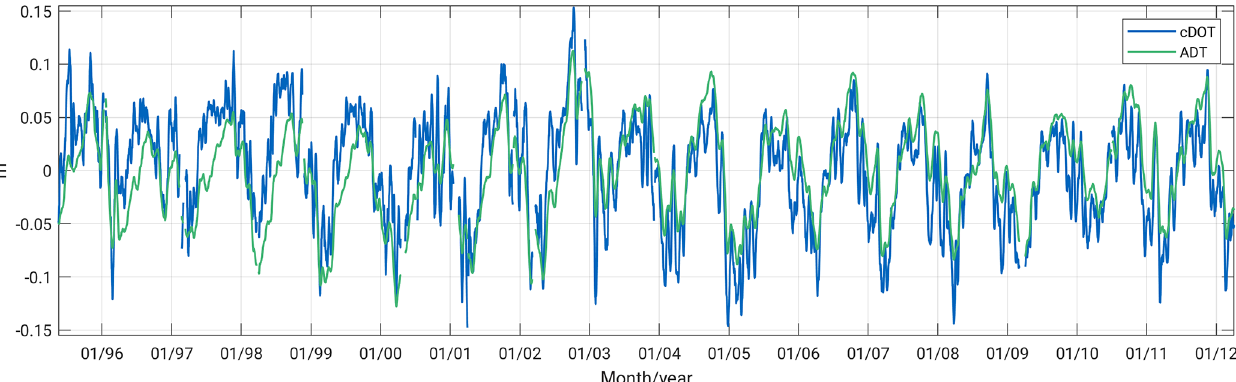
Figure 11. Zero-centered time series of daily and spatially averaged altimetry-only ADT grids and to the ADT grid nodes interpolated combined DOT (cDOT) limited to ice-free regions within 1995–2012 and the northern Nordic